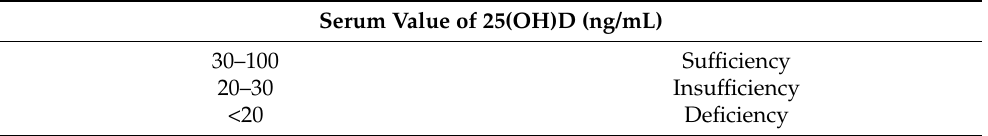
Table 1. 25(OH)D thresholds and respective serum